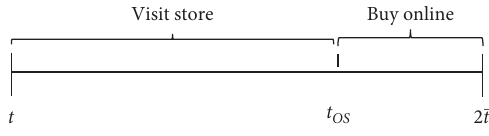
Figure 2: Consumers’ channel choice in